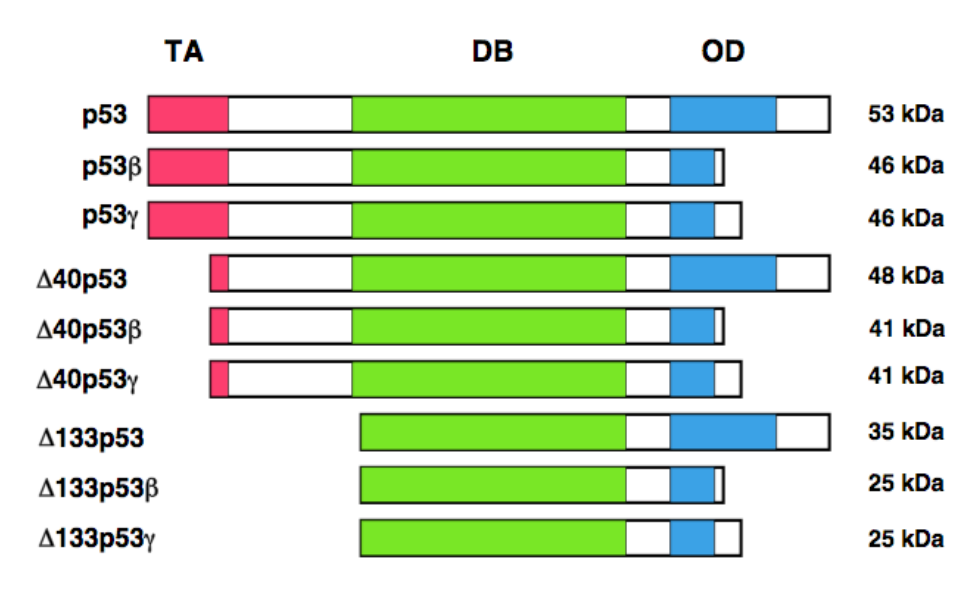
Figure 3. Structure of p53 variants. TA, transactivation domain; DB, sequence-specific DNA-binding domain; OD, oligomerization domain. Estimated molecular weights are also